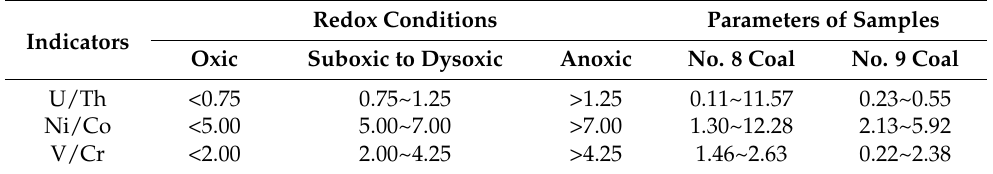
Table 10. The discrimination index of redox environmental and corresponding parameters of samples